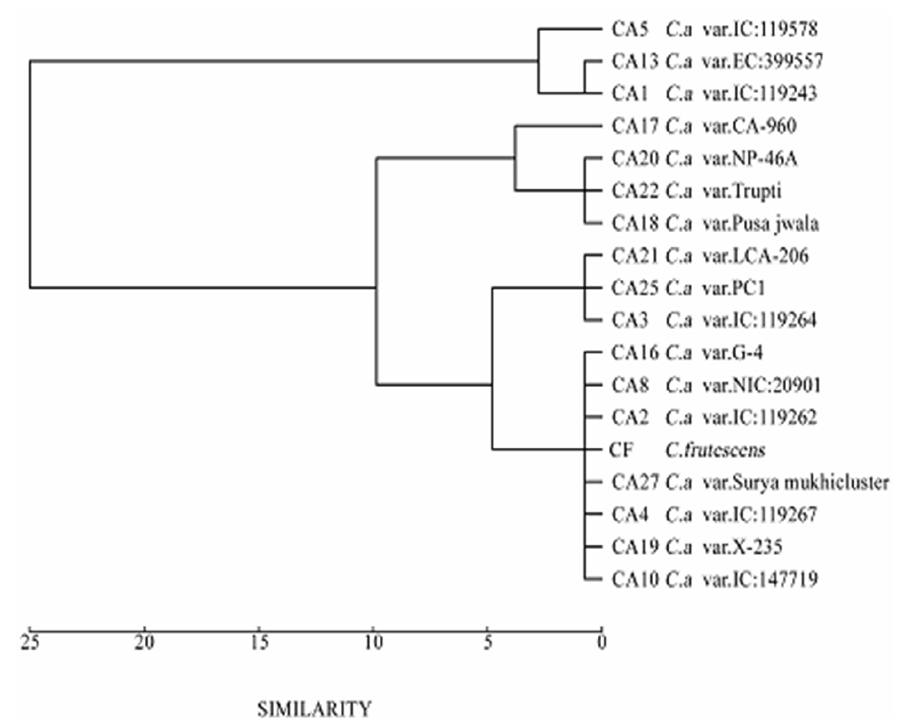
Fig. 2. UPGMA dendrogram of eighteen genotypes of chili pepper ( Capsicum L.) based on seed storage protein